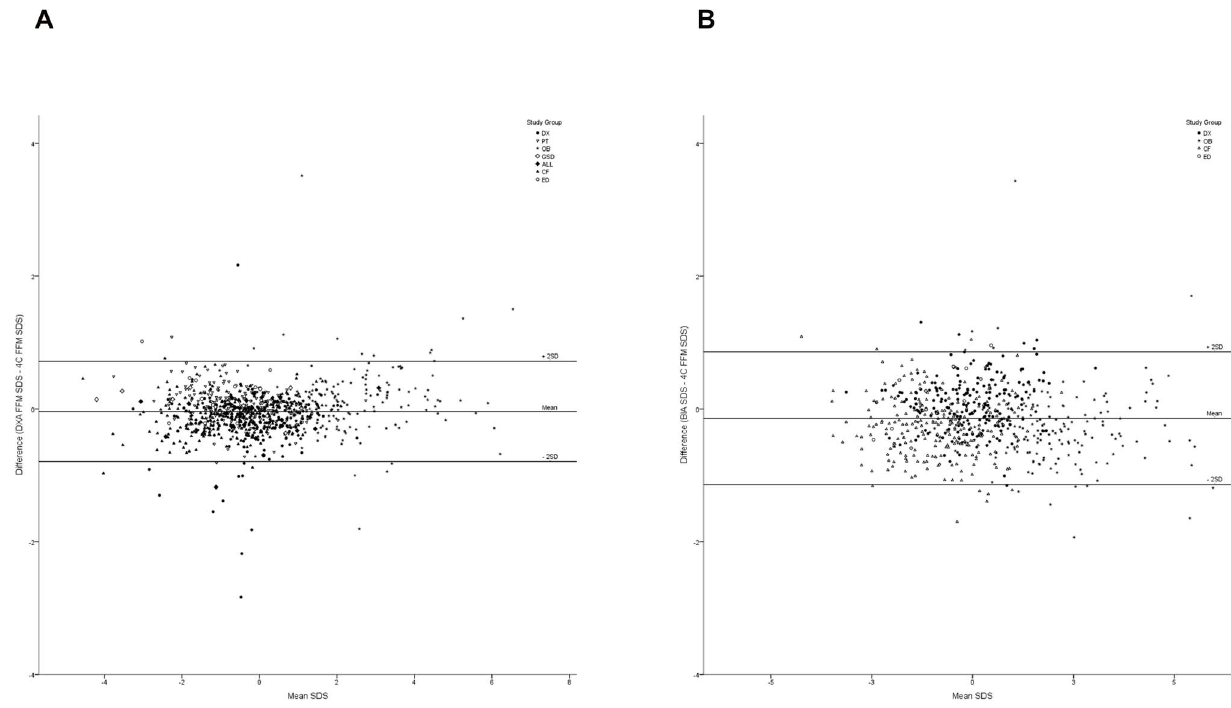
Figure 2. Bland-Altman analyses for the agreement between the 4C model and (A) DXA and (B) BIA in the measurement of FFM. As for Figure 1, SD scores (SDS) were calculated using ICH reference data [2]. Difference in SDS between techniques was calculated by subtracting 4C FFM SDS from the FFM SDS given by the ‘simpler’ method. Horizontal lines on the graph indicate the mean difference between techniques, and two standard deviations above and below this value. Different symbols indicate which study group each subject was from, as shown in the key. 4C model; four-compartment model, DXA; dual-energy X-ray absorptiometry, BIA; bioelectrical impedance analysis. DX; healthy children, PT; young adults born preterm, OB; obese children, GSD; glycogen storage disease, ALL; acute lymphoblastic leukaemia, CF; cystic fibrosis, ED; eating